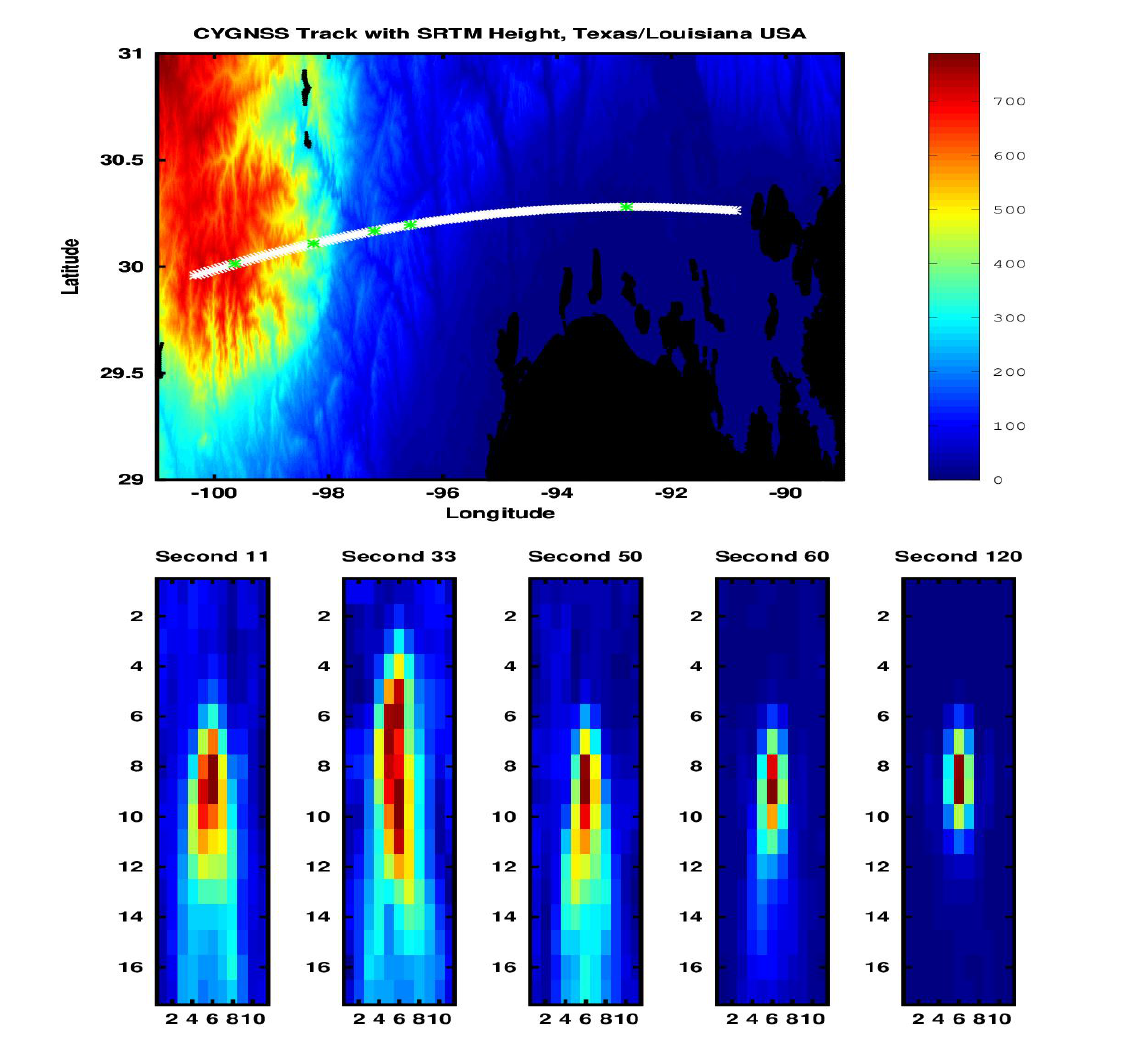
Figure 2. ( top ) Example Cyclone Global Navigation Satellite System (CYGNSS) reflection track over changing terrain. Image background is Shuttle Radar Topography Mission (SRTM) height map in meters. CYGNSS track shown as white arch traveling from west to east, green stars along track indicate Delay Doppler Map (DDM) locations. Second 11 is the western most green star, Second 120 is the eastern most. Water regions shown in black. ( bottom ) Example DDMs at points along the track from various terrain